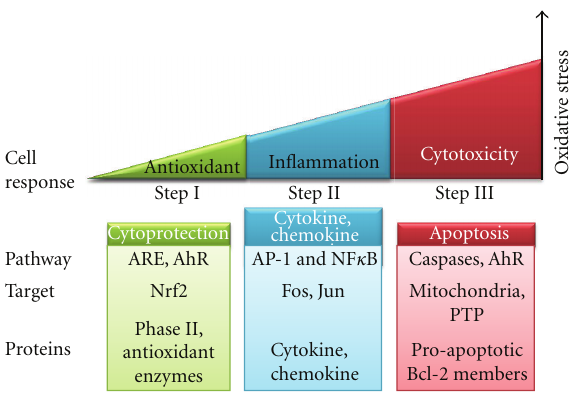
Figure 2: Hierarchical oxidative stress model in response to air pollutants. Low ROS production (Step I) induces activation of cellular antioxidant systems to restore redox homeostasis. If this protection is insu ffi cient, the increased stress (Step II) triggers an inflammatory response through MAPK and NF κ B pathways. At a final stage (Step III), all the defense systems are overwhelmed and high ROS levels lead to PTP opening and cell death by apoptosis. These responses depend on the pro/antioxidant balance which varies from one living being to another (adapted from